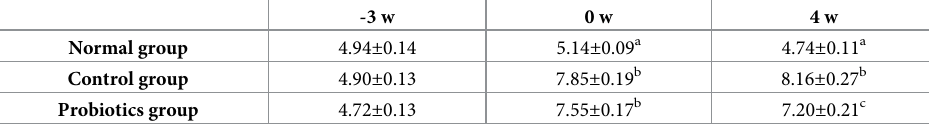
The normal group (N = 20) was untreated. The control group (N = 20) and the probiotics group (N = 20) received adenine orally from Week -3 to Week 0 to induce CKD. The control group received PBS orally from Week 0 to Week 4. The probiotics group received probiotics dissolved in PBS orally from Week 0 to Week 4. When the Bartlett test did not detect any significant deviation, a one-way analysis of variance was performed to determine whether there were any differences in the means of the three groups. Then, the significance of the intergroup mean differences was examined using Bonferroni’s test. A non-parametric comparison using the Kruskal–Wallis H test was performed if a deviation from variance homogeneity was significant. The level of significance was set at p < 0.05. Data are presented as means ± standard errors. a, b, c Different letters within columns indicate differences between the treatment groups ( p < 0.05). CKD, chronic kidney disease; PBS, phosphate-buffered solution